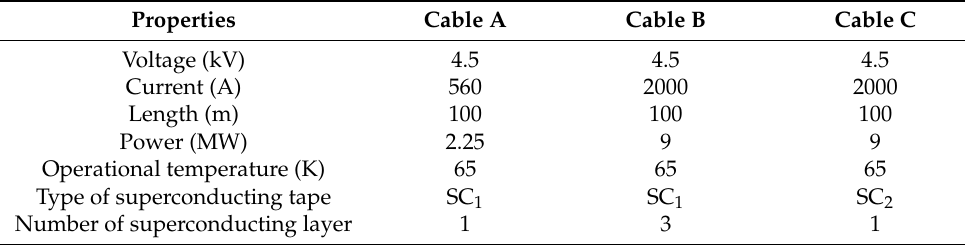
Table 2. The specifications of the understudied DC HTS cables.